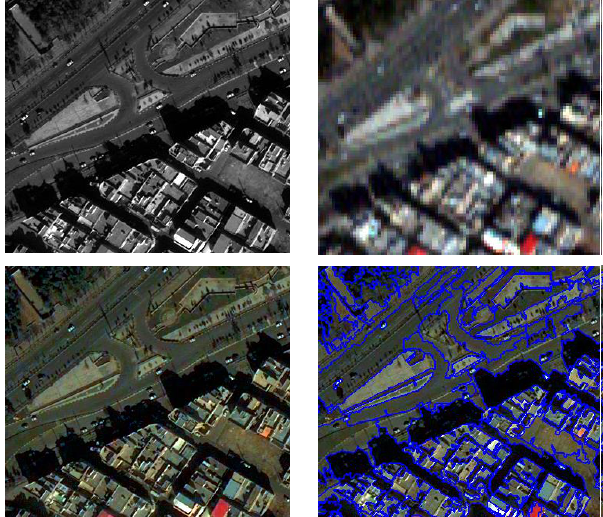
Figure 3. Original panchromatic and spectral bands (top), result of image fusion and image segmentation